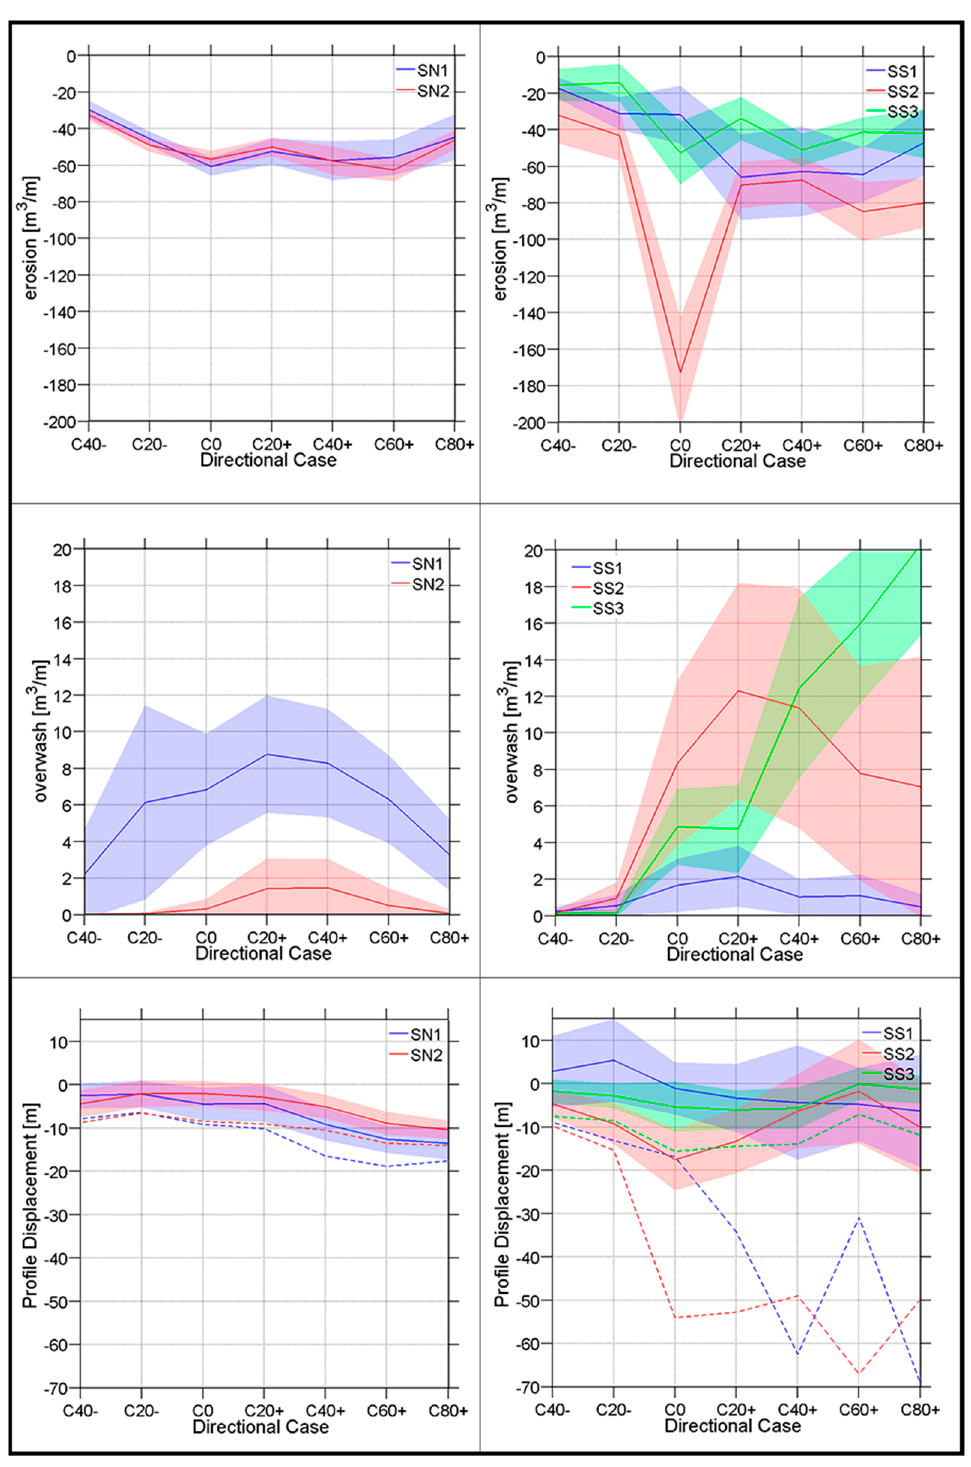
Figure 10. Variation of simulated morphodynamic parameters (see text for description) at selected control areas the N ( left ) and S ( right ) coasts for tested storm directions (see Figure 4 or Figure 8 for location). Continuous lines denote variable mean, shaded areas represent standard deviation and dashed lines indicate maximum profile retreat at each sector.